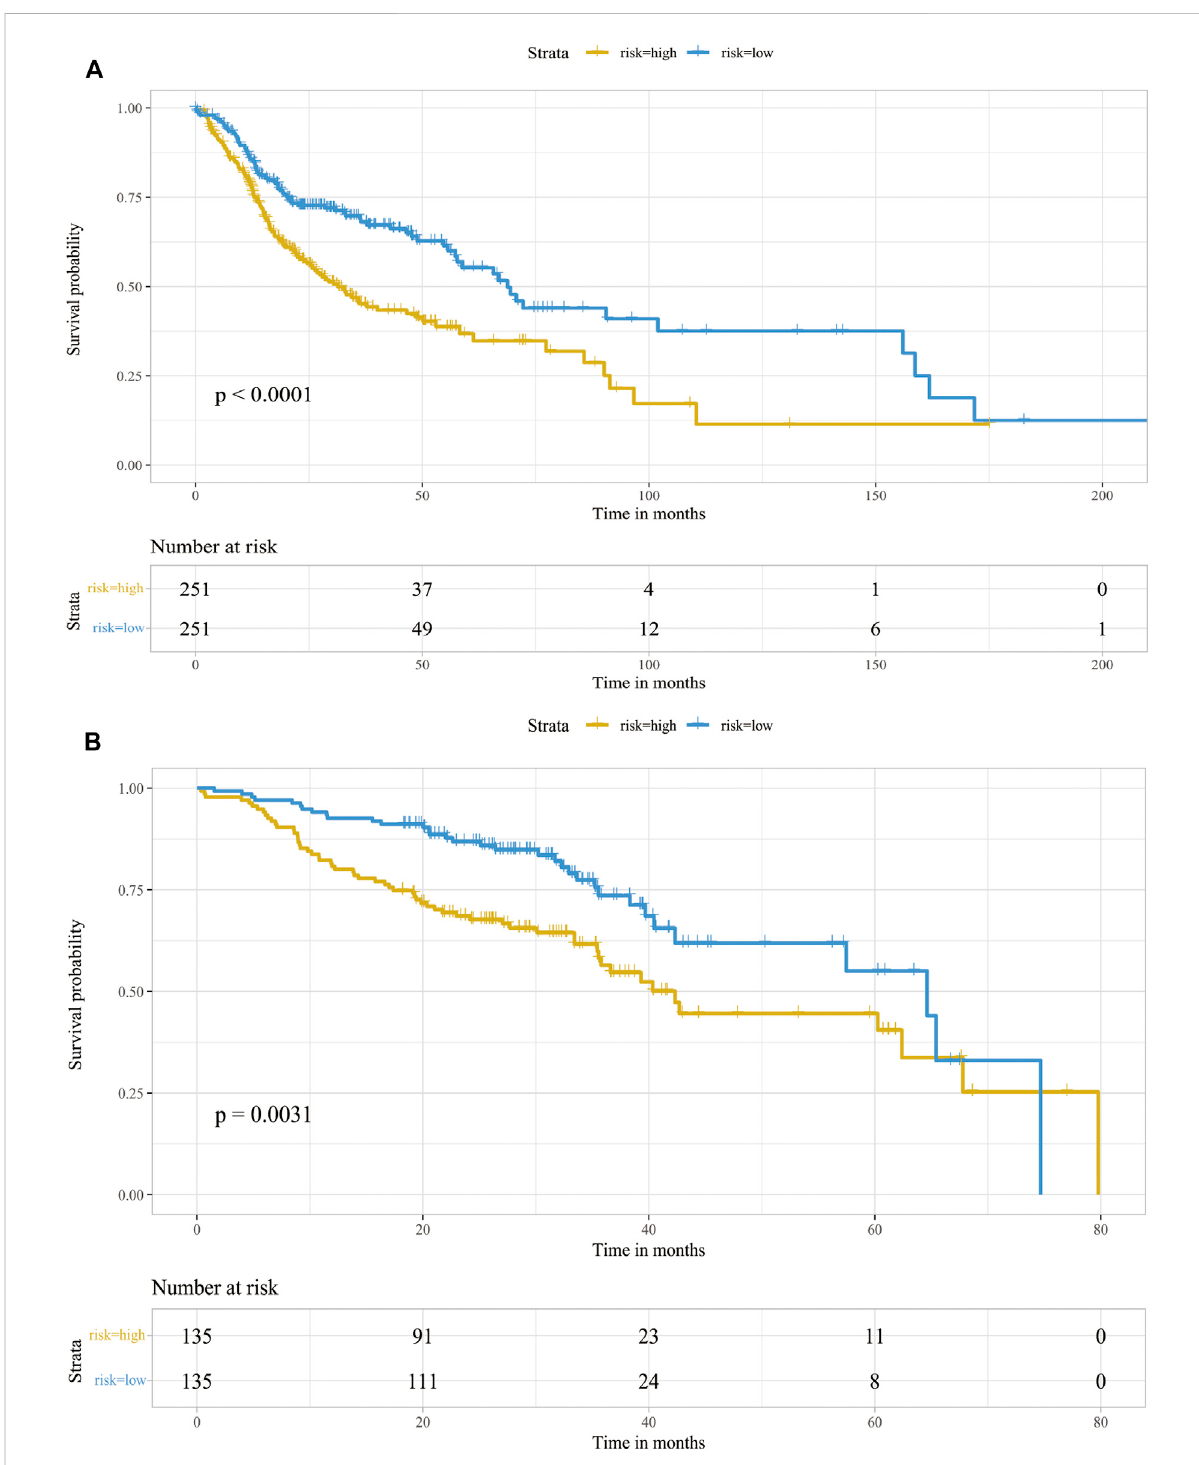
FIGURE 4 Prognostic analysis of the in fi ltrations of CAFs. Kaplan-Meier survival curve of CAF subgroups in TCGA-HNSC cohort (A) , GSE65858 (B) and GSE42743 (C) .Patients were strati fi edinto twogroups according to its CAFrisk score. The table atthebottom showed thenumber ofpatients at risk in each